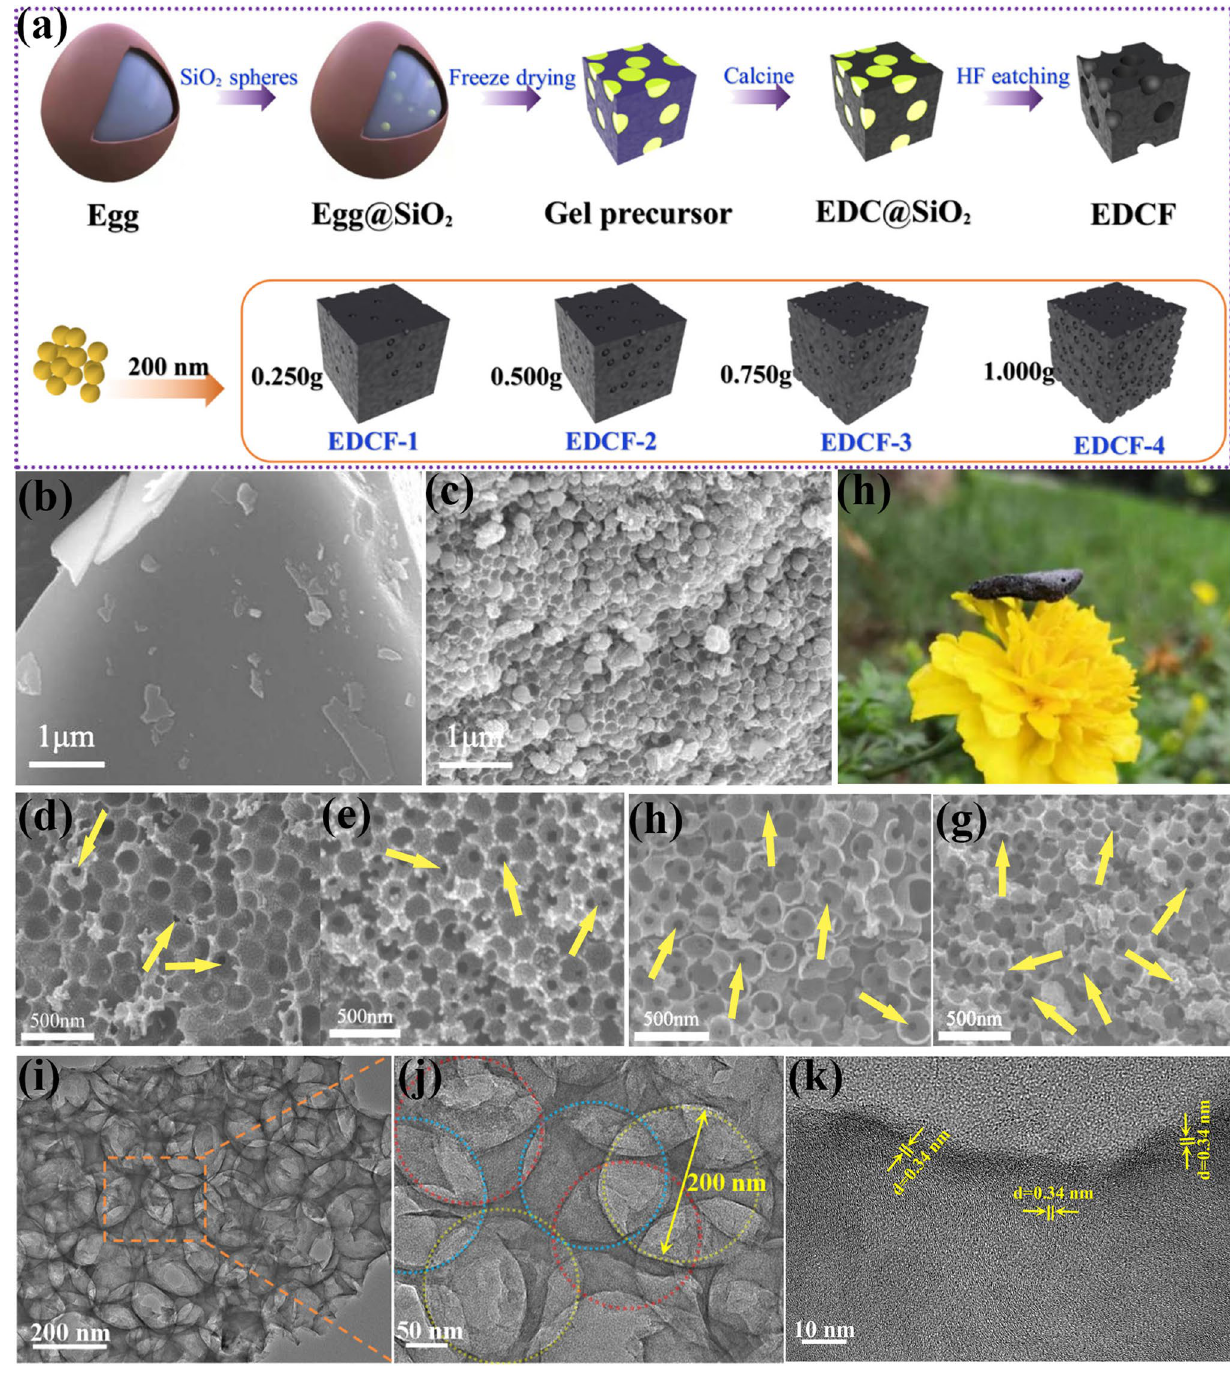
Fig. 1 a Schematic illustration of the synthesis process of EDCF samples with different amounts of 200 nm silica microsphere addition; b SEM images of EDC and c EDC@SiO 2 nanocomposites; d – g SEM images of EDCF-1 ~ EDCF-4 samples; h the photograph of free-standing EDCF; i , j representative TEM images and k HRTEM images of EDCF